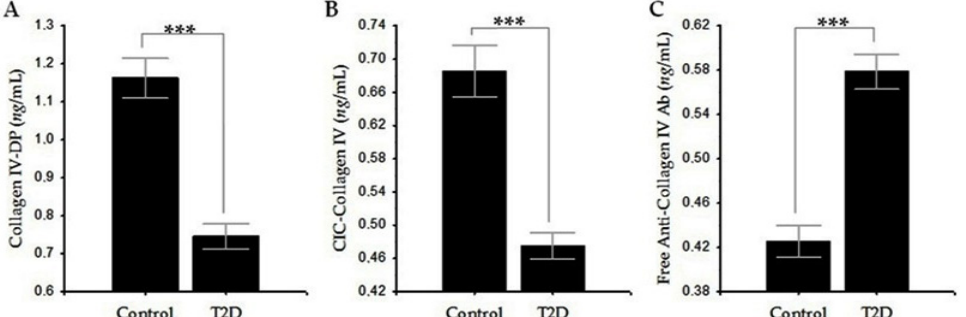
Figure 2. ( A ) Serum levels of CIV-DP in T2D group vs. control group. ( B ) Serum levels of CIC-CIV in T2D group vs. control group. ( C ) Serum levels of free ACIVAbs IgG in T2D group vs. control group. Data are represented as mean ± SD. *** p < 0.001.